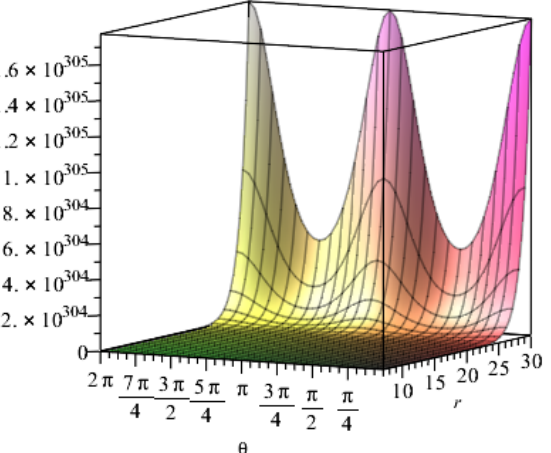
Figure 8. Relationship between the resistance value of the embedded carbon fibre and the radius of the tunnel.